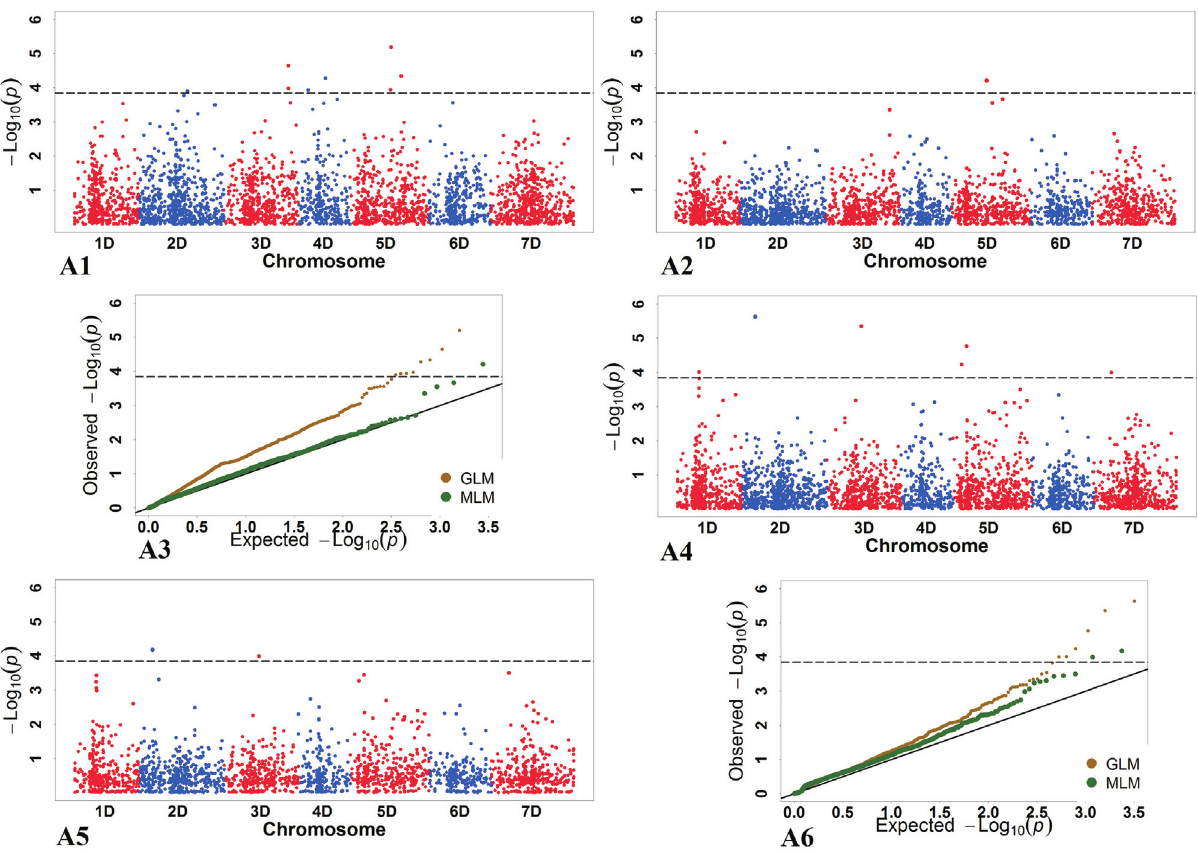
Figure 1 - The p values of the SNPs and quantile-quantile (Q-Q) plots of p values for total dry weight (TDW) under the normal condition (NC) and the PEG-induced, simulated drought-stress condition (SC). Summary of GWAS results for TDW. A1 and A2) GLM and MLM results for association under NC condition. A3) Q-Q plots of GLM and MLM under NC condition. A4 and A5) GLM and MLM results for association under SC condition. A6) Q-Q plots of GLM and MLM under SC